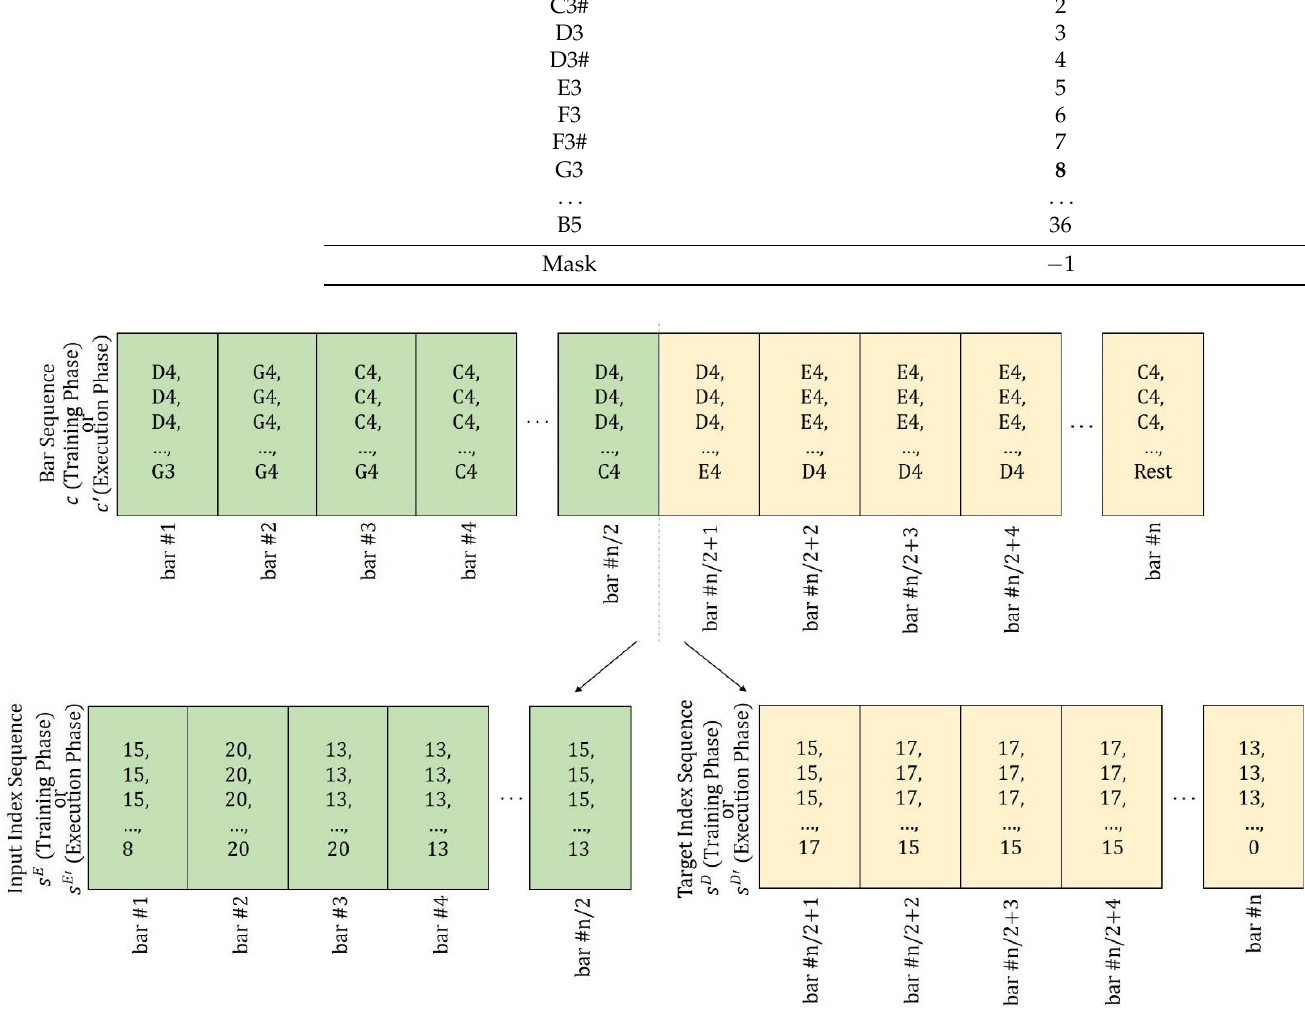
Figure 5. Process of the index converter.